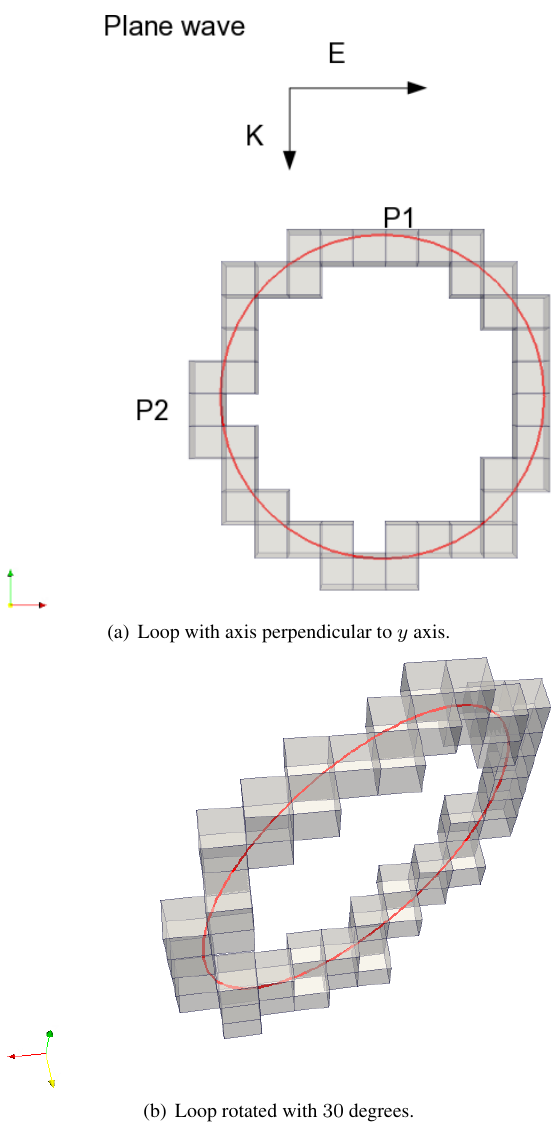
Figure 9: The two configuration studied for the circular loop